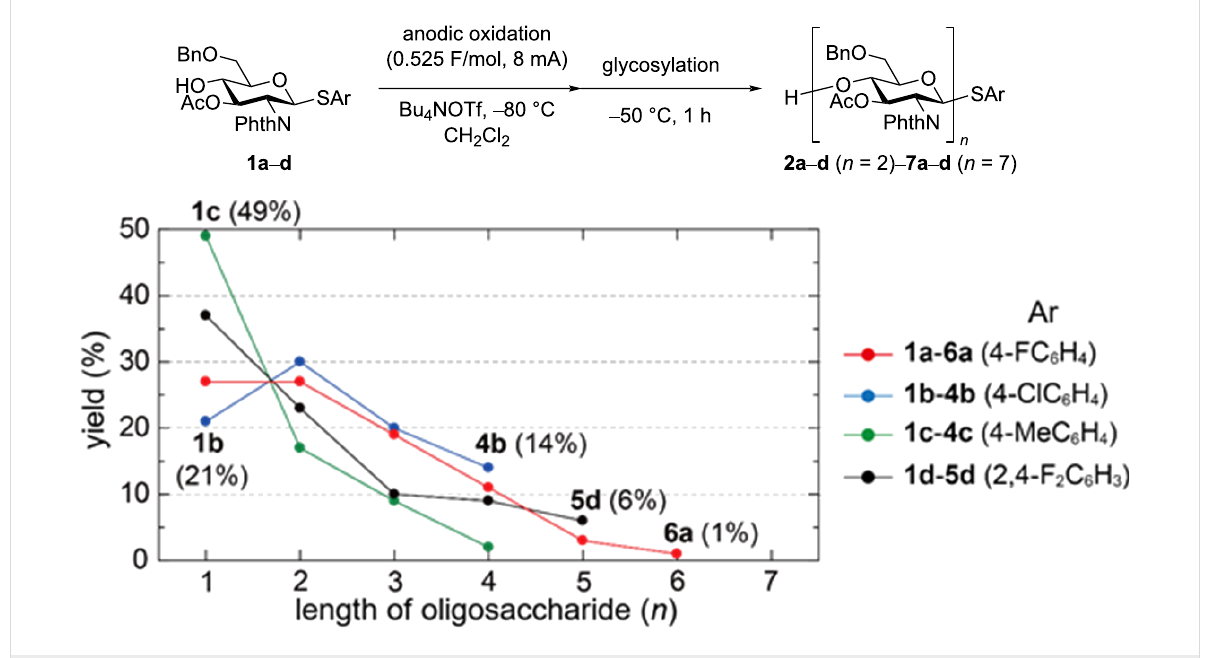
Figure 2: Effect of the anomeric leaving group on the yield of oligosaccharides.